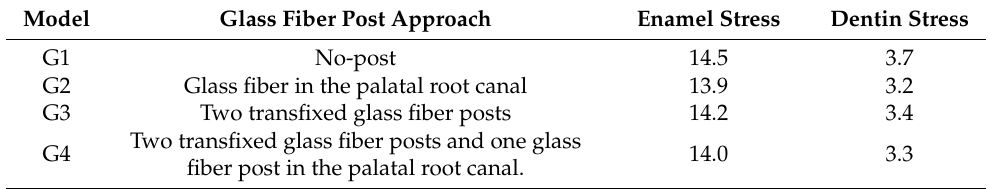
Figure 7. The von-Mises stress (MPa) concentration from five different viewpoints in the dentin tissue according to the GFP treatment. Table 2. Tensile stress peaks (MPa) obtained in enamel and dentin tissue after the analysis process. Model